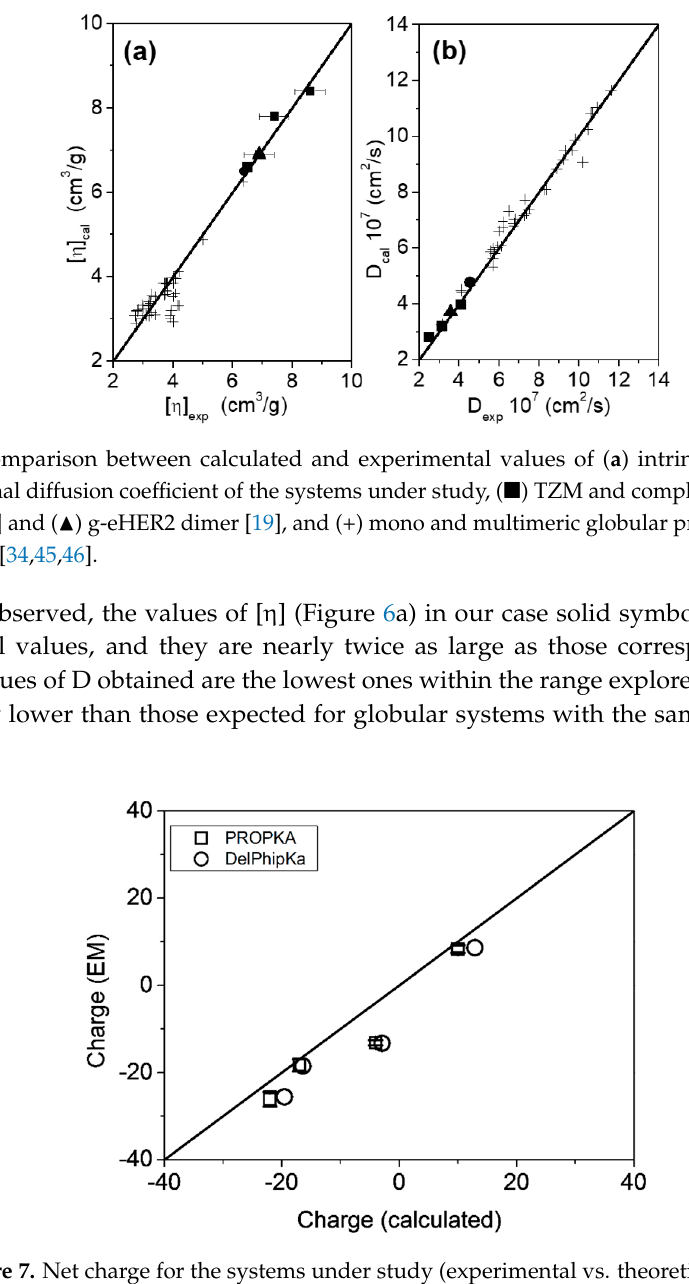
Figure 7. Net charge for the systems under study (experimental vs. theoretical data).